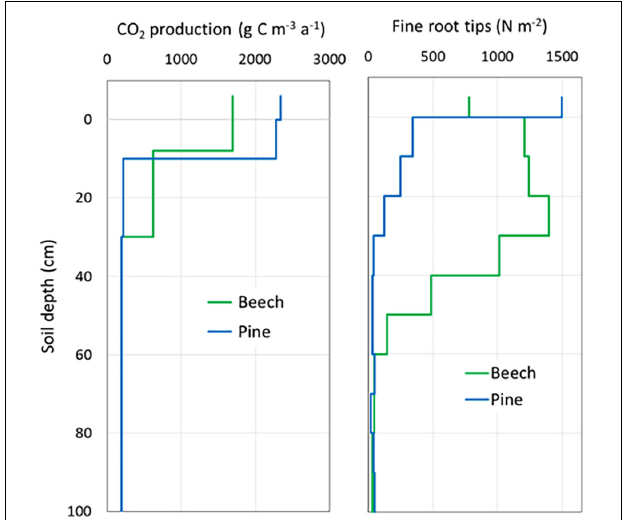
FIGURE 4 | Vertical distribution of volume-related CO 2 production rates as mean values over the entire study period (left) and the number of fine root tips (right) in soils of the beech stand and the pine